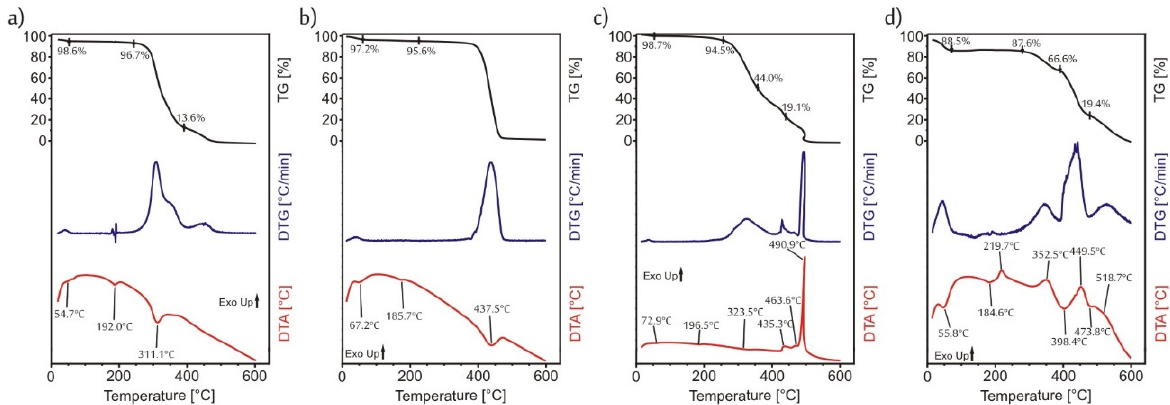
Figure 3. TG/DTA measurements, ( a ) PVA in N 2 ; ( b ) PVP in N 2 ; ( c ) PVA in air; ( d ) PVP in air.